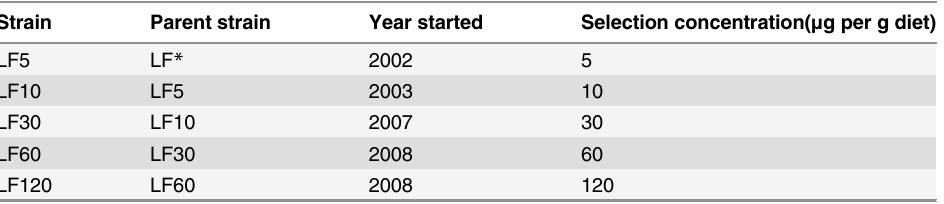
Table 2. Origins of Cry1Ac-resistant strains of H .